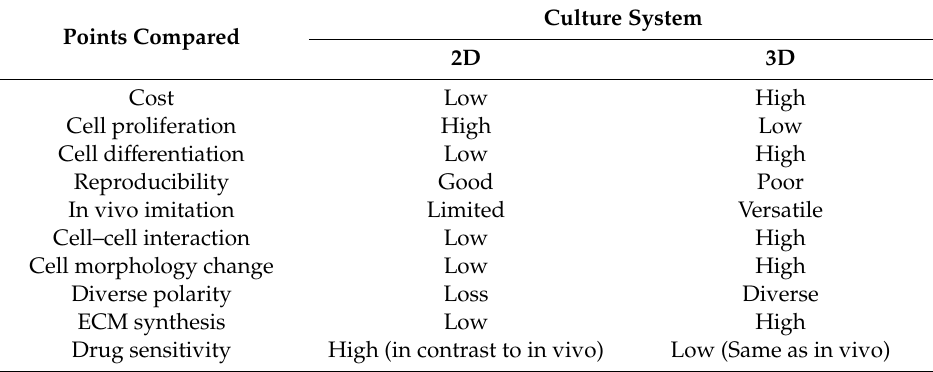
Table 1. Comparison of cancer cells culture between 2D and 3D